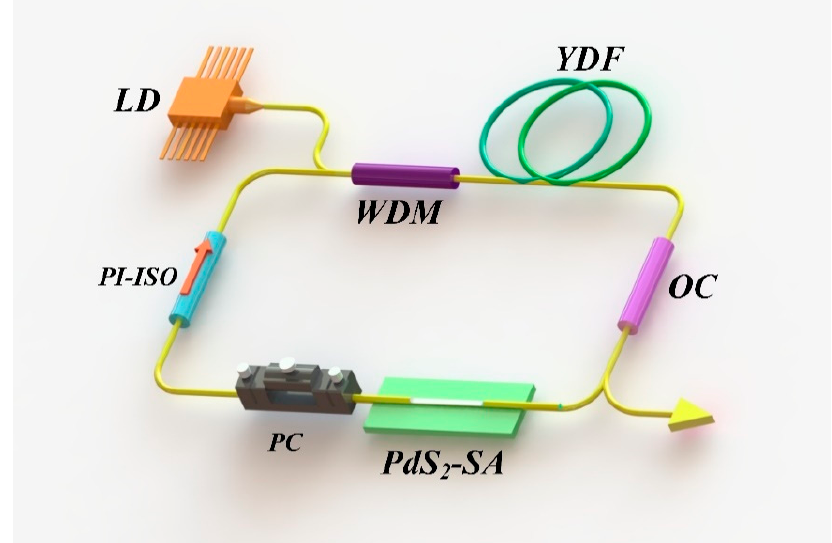
Figure 5. Schematic illustration of passively mode-locked YDF lasers based on PdS 2 SA. LD: laser diode. WDM: wavelength division multiplexer. YDF: ytterbium-doped fiber. OC: output coupler. PdS 2 -SA: PdS 2 saturable absorber. PC: polarization controller. PI-ISO: polarization independent isolator.